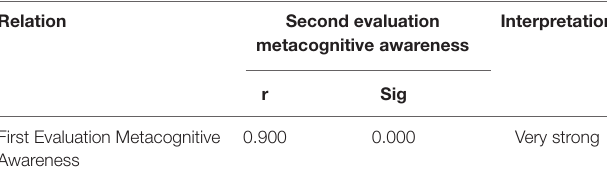
TABLE 7 | Pearson’s correlation coefficient index r metacognitive awareness.